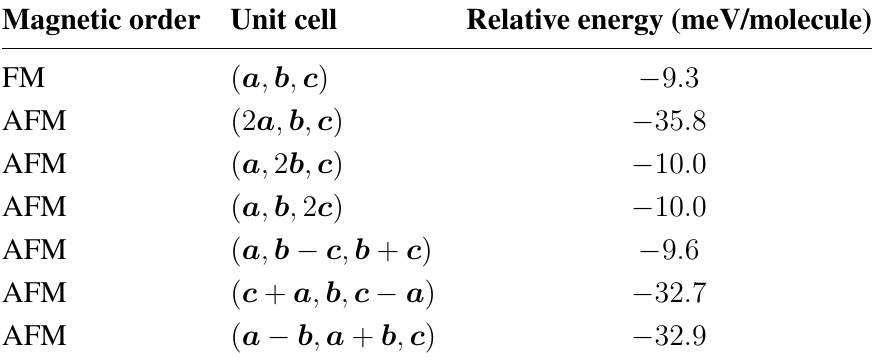
Table 1. Relative energies for the one FM and six AFM states against the NM